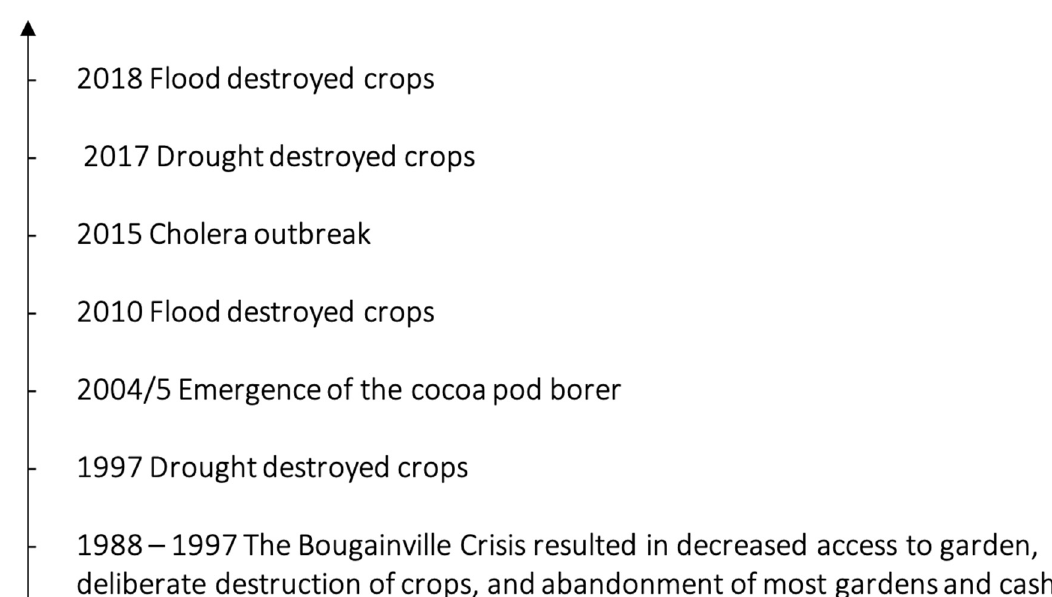
Figure 3. Timeline of stresses and shocks to the food